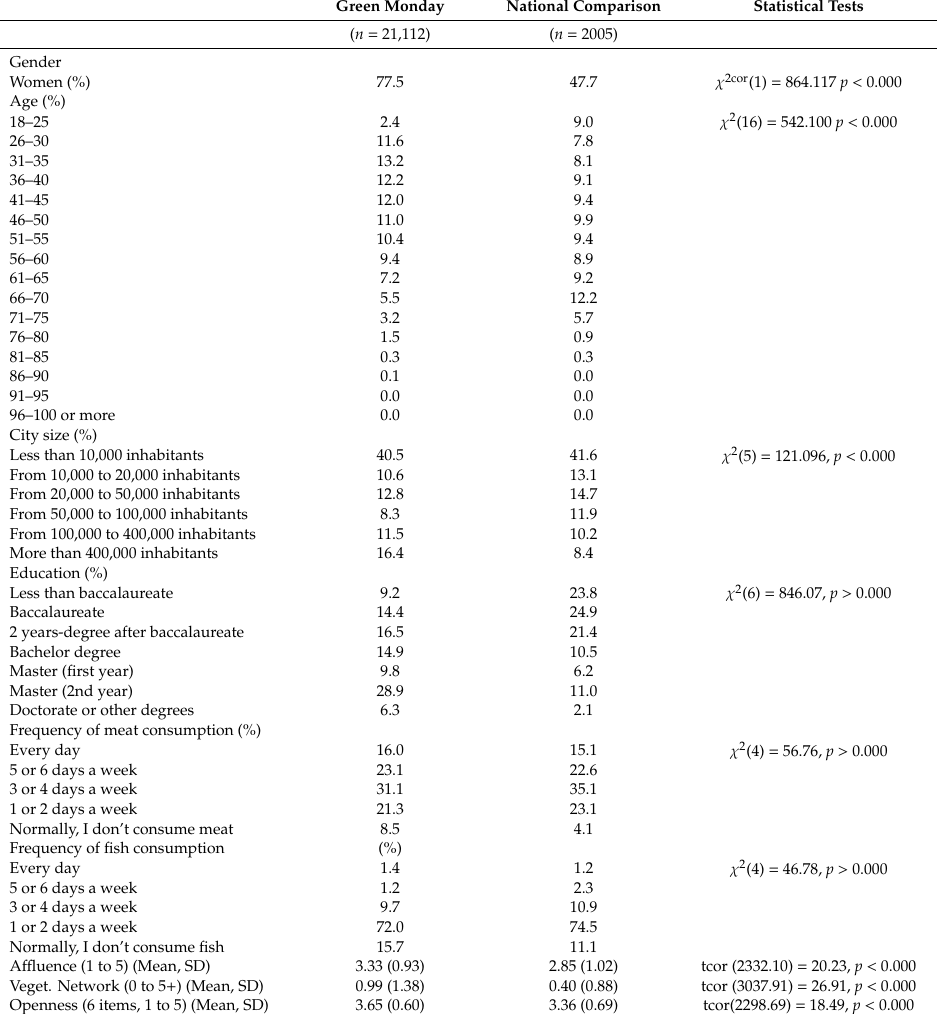
Table 1. Characteristics of the two samples and univariate comparisons. Green Monday National Comparison Statistical